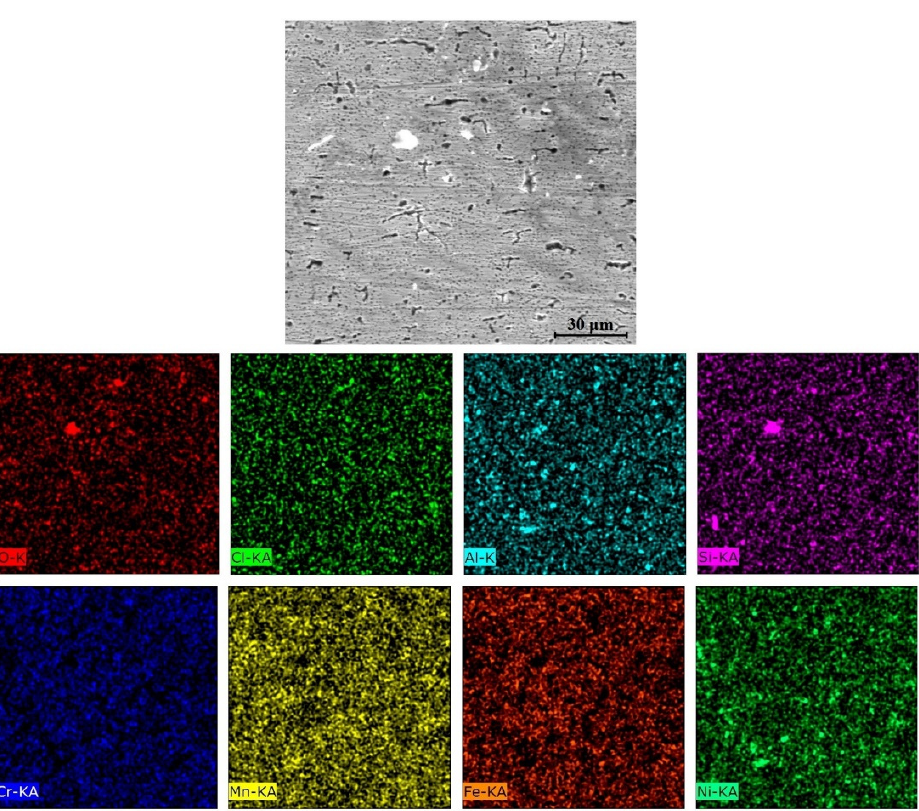
Figure 15. EDX elemental mapping of the corroded solution-treated (CR + ST) Fe 36 Mn 20 Ni 20 Cr 16 Al 5 Si 3 HEA in 0.6 M NaCl with 0.5 M H 2 SO 4 .